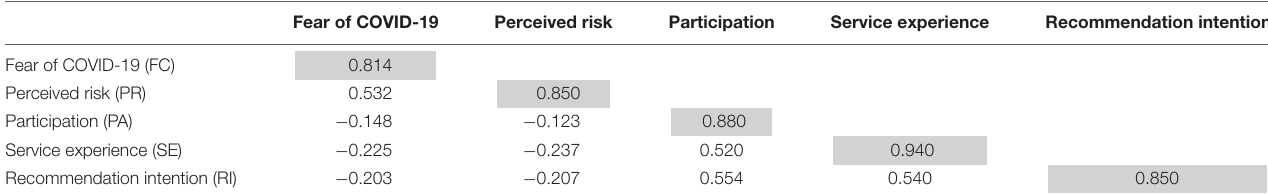
TABLE 3 | Fornell–Larcker